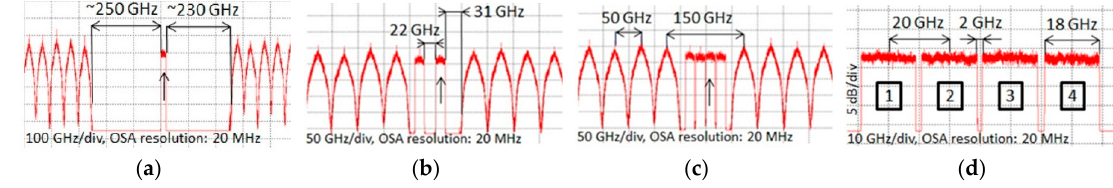
Figure 3. Spectra of: ( a ) a single-channel transmission of a single-band DP, 16-ary quadrature amplitude modulation (QAM) orthogonal frequency division multiplexing (OFDM) signal, ( b ) Wavelength division multiplexing (WDM) transmission with a 2-band DP, 16QAM OFDM signal, ( c ) WDM transmission with a 4-band, DP, 16QAM OFDM super-channel at the center of the WDM comb and ( d ) the multi-band (MB) OFDM super-channel. The black arrow, in each case, indicates the band under measurement.